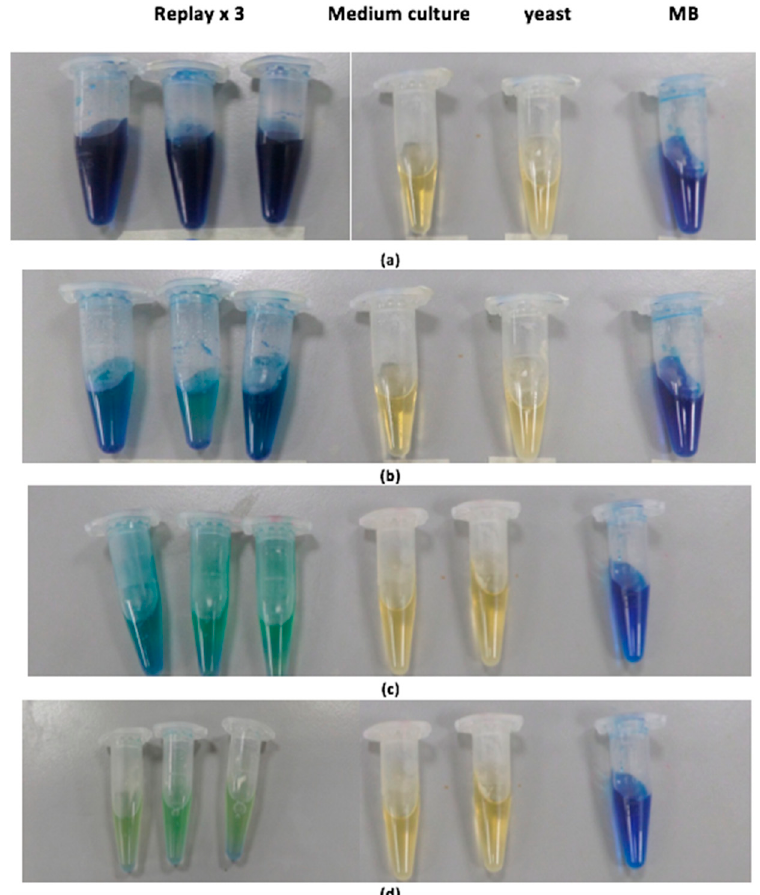
Figure A1. Tests of biodegradation of MB dye by the action of the yeast Galactomyces geotrichum KL20A. ( a ) Time zero hours, ( b ) Time 12 h, ( c ) Time 24 h, ( d ) Time 48 h, (MB concentration was 50 ppm and temperature was 30 °C). The images on the left correspond to replays (×3) of the degradation experiments. The images on the right correspond to the controls used in order of yeast, culture medium (YPD-broth).